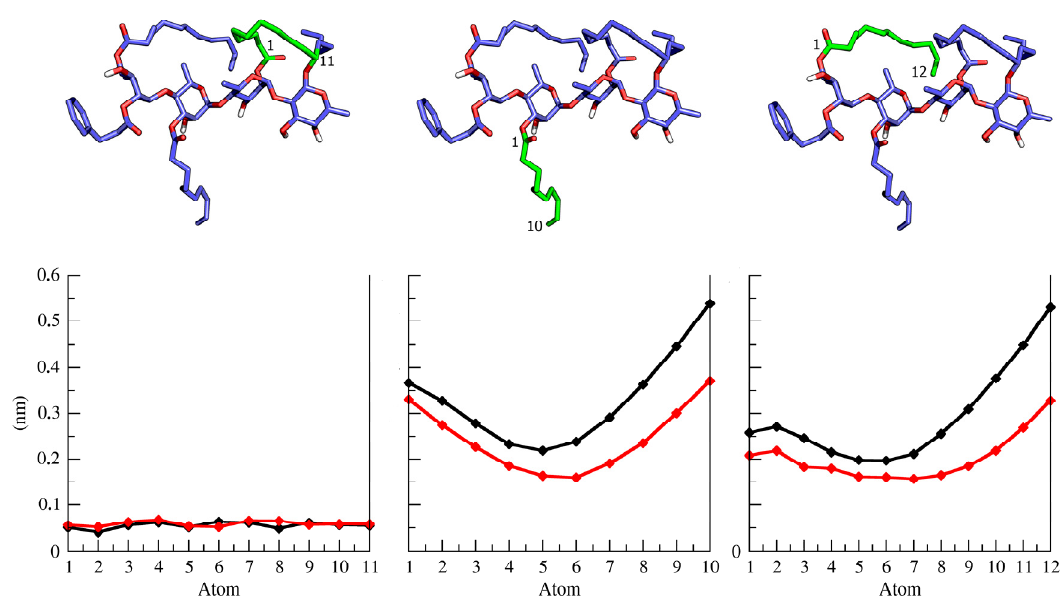
Figure 3. Root mean square fluctuation (RMSF) for ipomotaoside A macrocycle and acyl chains. A tridimensional representation of each structure is highlighted in green, at the top, and the corresponding RMSF is at the bottom. Aqueous solution is represented in black and pyridine is indicated in